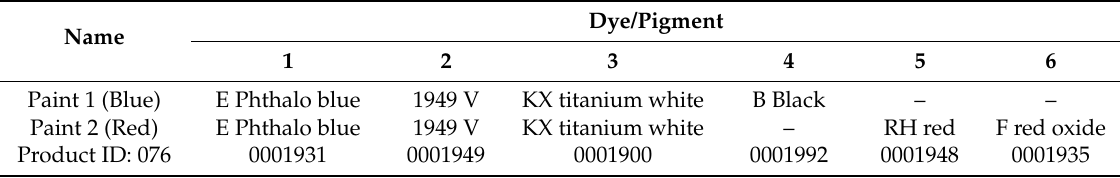
Table 2. Paint composition in dyes and